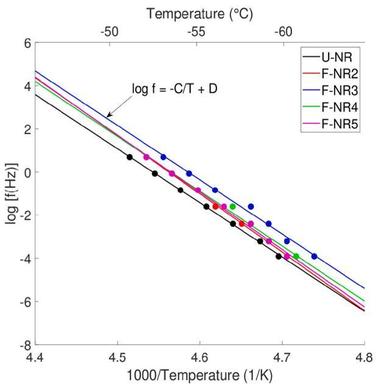
Using the loss tangent peaks to find the activation energy for the glass transition in U-NR and the four F-NRs.